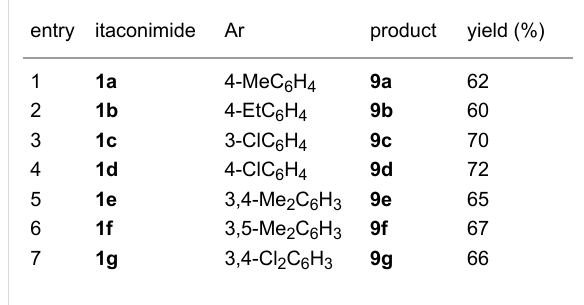
Table 1: Yields of the interaction products 9 of N -arylitaconimides 1a – g and diaminoimidazole 4